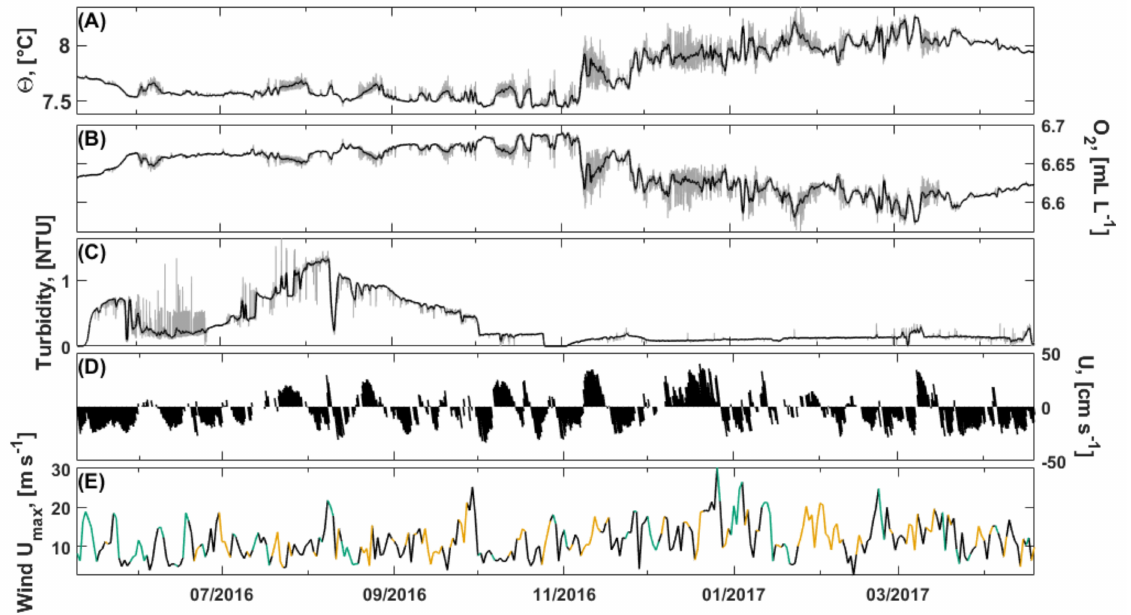
Figure 4. Nakken bottom water (~210 m) characteristics for ( A ) temperature, ( B ) oxygen, ( C ) turbidity, ( D ) daily mean horizontal flow velocity (up northward and down southward flow) at Nakken, and ( E ) daily maximum wind speed from Utsira coastal station based on data from MET Norway. The prevailing wind directions are marked with green (northerly from NW (315 ◦ ) to NE (45 ◦ )) and yellow (southerly from SE (135 ◦ ) to SW (225 ◦ )). The thicker line (in three first rows) shows the 1-d running